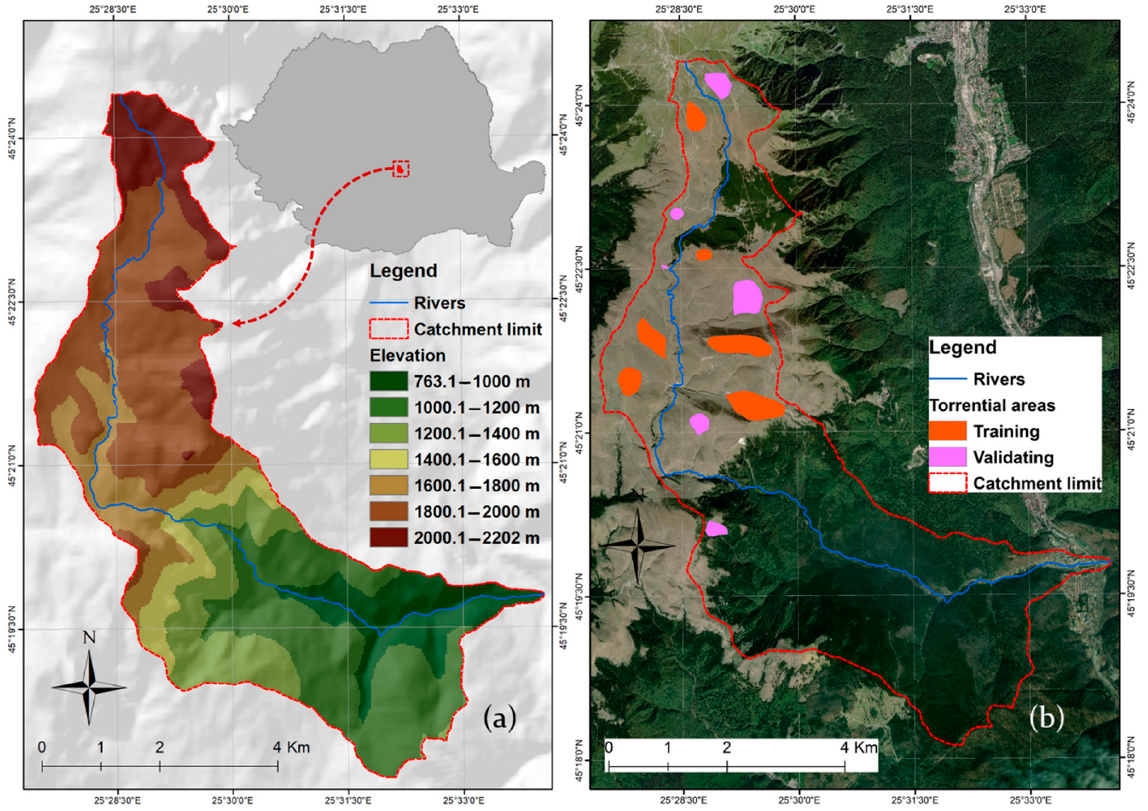
Figure 1. The study area. ( a ) Study area location in Romania; ( b ) torrential area location.